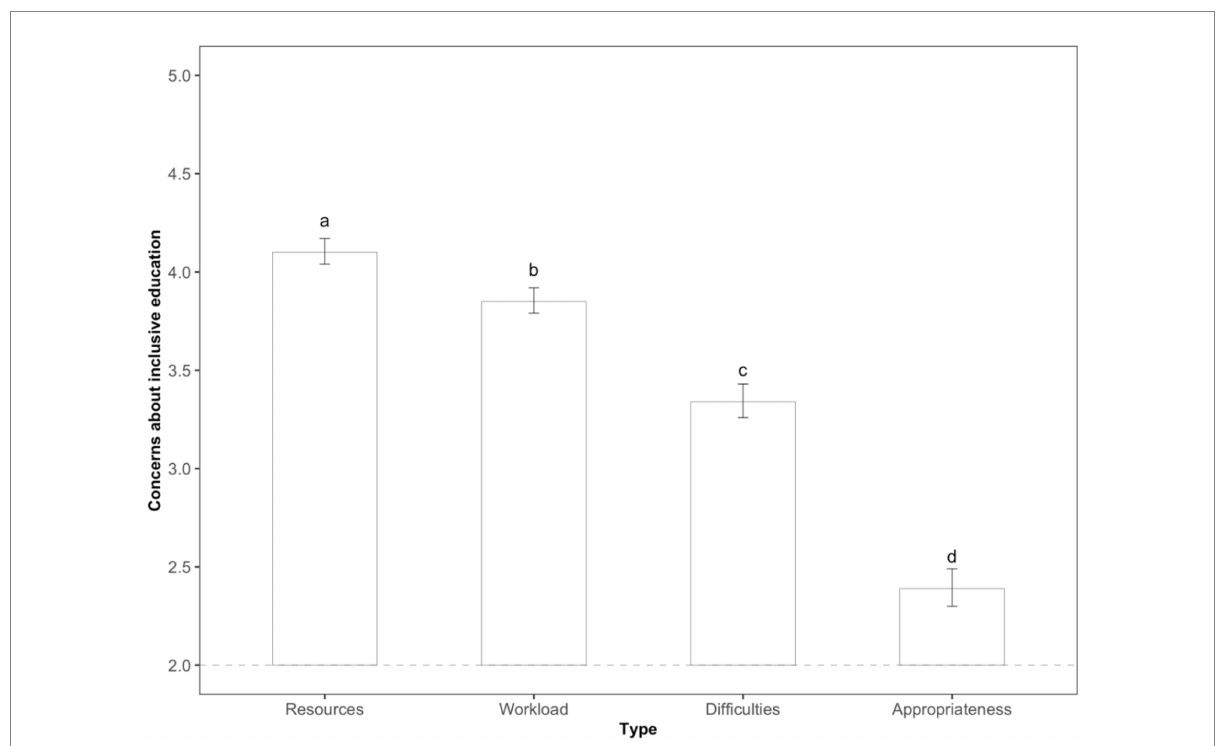
FIGURE 1 French teachers’ concerns about inclusive education. Different letters indicate significant differences between groups ( p < 0.05). Error bars represent 95%